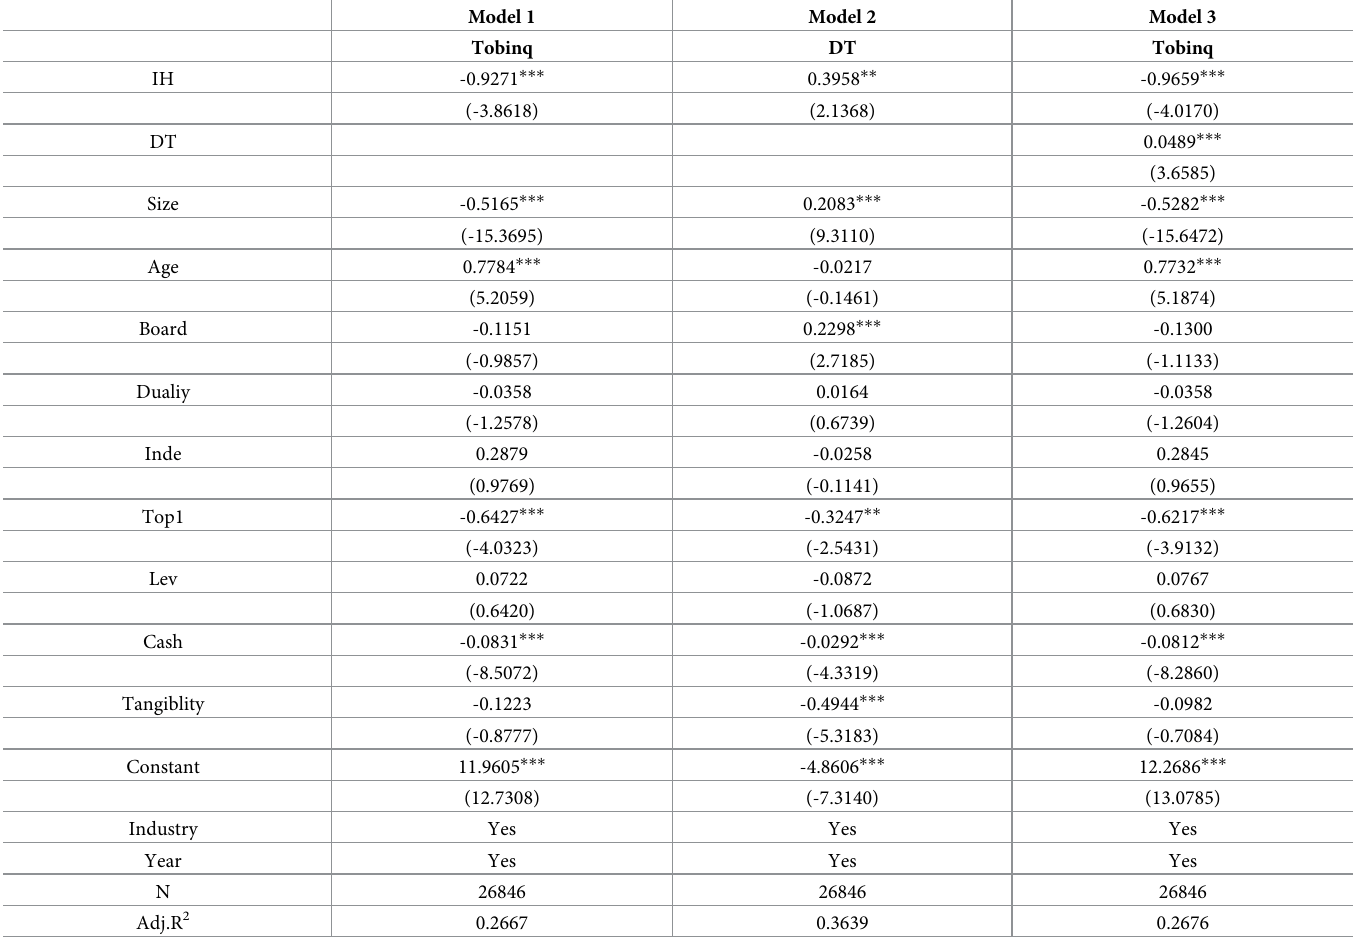
Table 9. The mediating mechanism of relationship between competitive pressure and firm